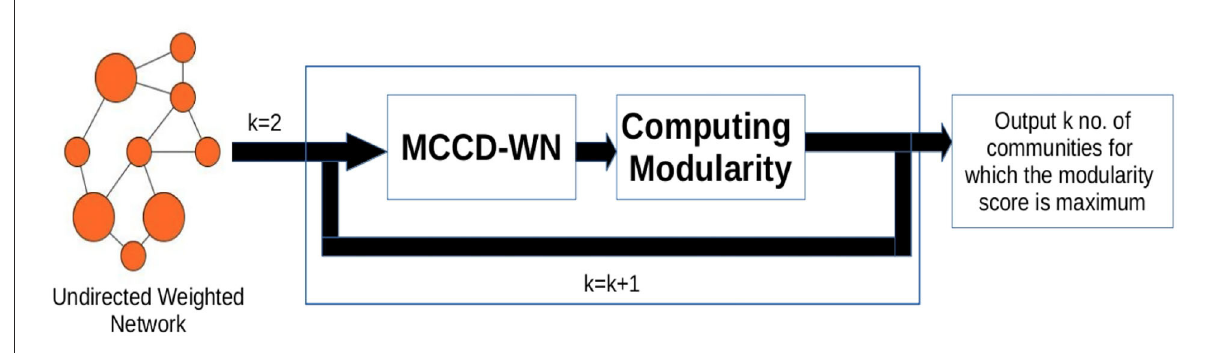
FIGURE3 Workflow for estimating the number of communities. k denotes the number of